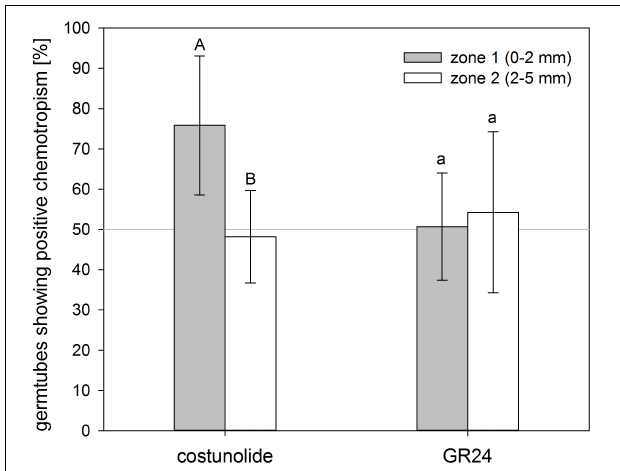
FIGURE 5 | Concentration dependence of O. cumana chemotropism toward costunolide. The values indicate concentrations applied to the filter discs (active concentrations at the seed surface are lower but undetermined). In tests with costunolide concentrations 10 − 6 M and 10 − 7 M, GR24 was added to ensure germination ( asterisk ). Means ± standard deviation of n = 3–6 replications. Same letter indicates that differences are not statistically significant (Tukey test, p <